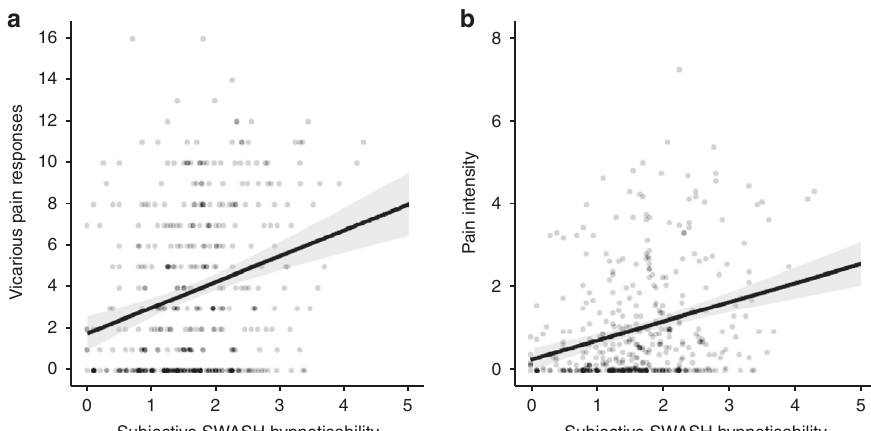
Fig. 1 Scatter plots showing linear regression of vicarious pain measures ( n = 404 participants) on hypnotisability. a Total pain responses on hypnotisability, Spearman ’ s r s = 0.26, 95% CI [0.17, 0.35]. b Pain intensity on hypnotisability, Spearman ’ s r s = 0.27, 95% CI [0.18, 0.36]. Error bars show 95% CI.The centre of credibility intervals is the predicted score. Note: SWASH is an abbreviation of Sussex-Waterloo Scale of Hypnotisability.